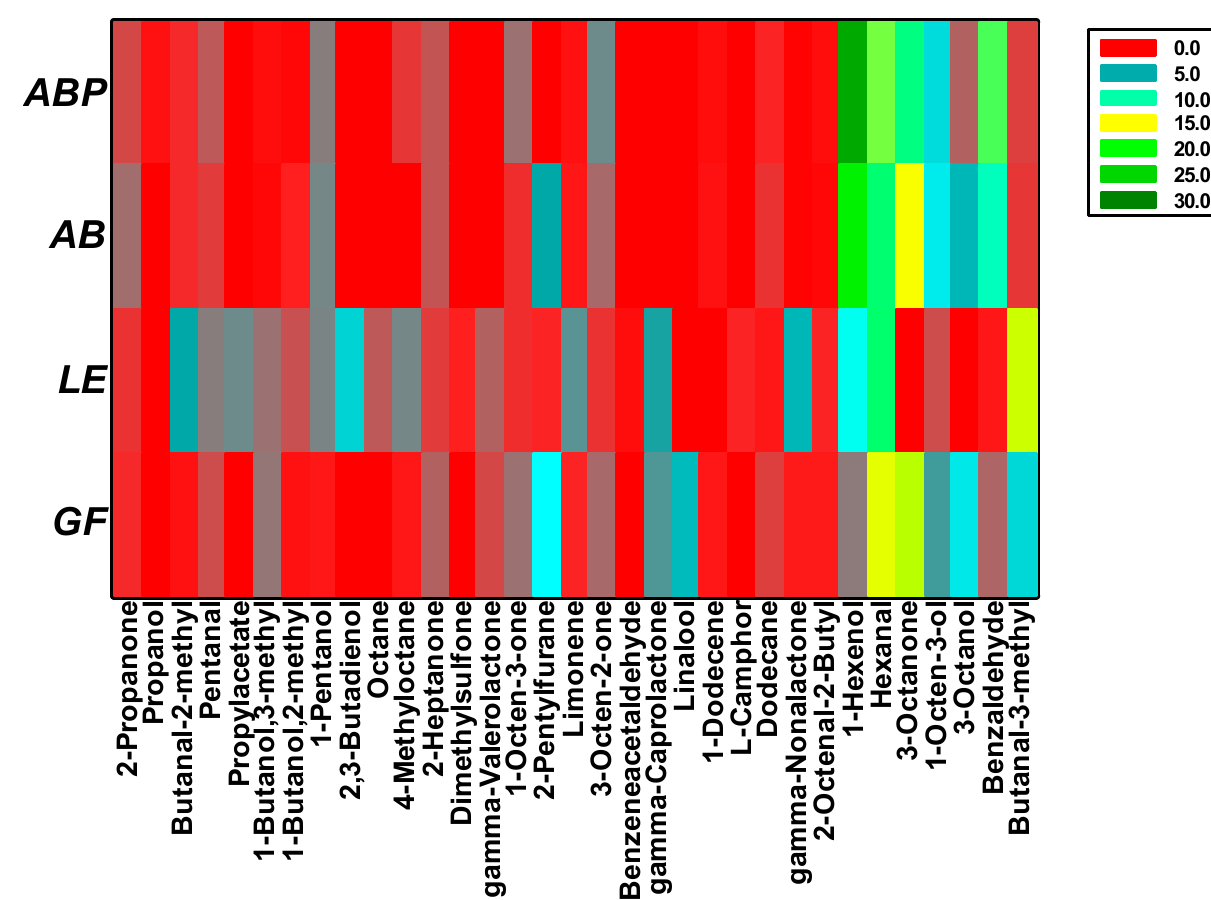
Figure 3. Percentage of most abundant VOCs, as detected by GC-MS, in the four freeze-dried samples under study (AB: Agaricus bisporus sp. bisporus ; ABP: Agaricus bisporus sp. brunnescens ; LE: Lentinula edodes ; GF: Grifola frondosa ) .